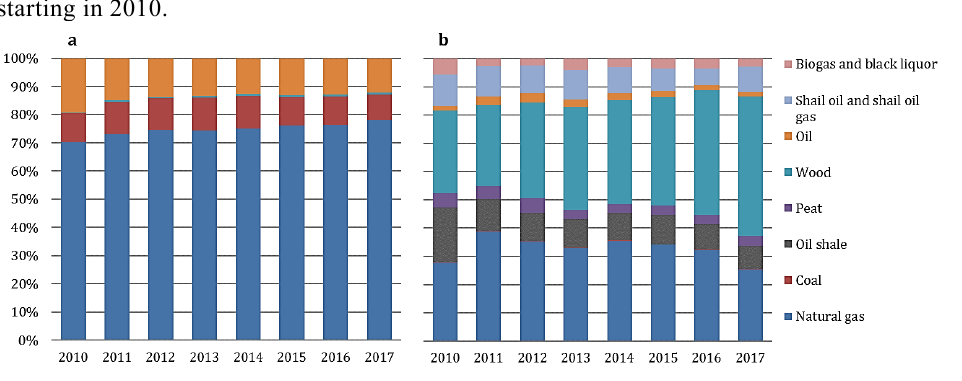
Fig. 2. Fuel consumption for DH in Serbia (a) and Estonia